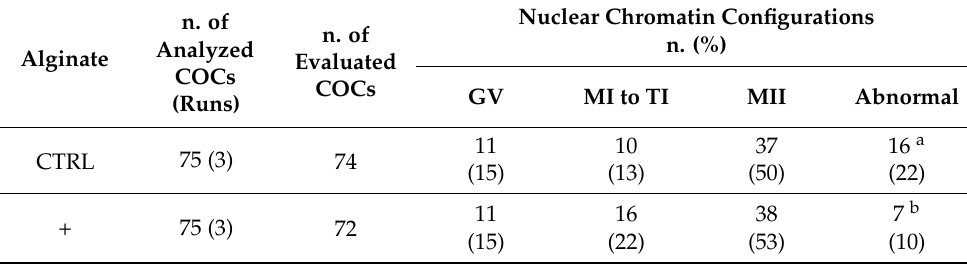
Figure 6. Effects of mIVM on sheep oocyte bioenergetic/oxidative status. Photomicrographs showing representative images of matured oocytes derived from static IVM (CTRL; ( a )); native mIVM ( b ); in alginate-filled supports ( c ). Corresponding epifluorescence images showing nuclear chromatin configuration (column 1: Hoechst 33258) and confocal images showing perinuclear and subplasmalemmal (P/S; ( a , c )) or finely granular ( b ) mitochondrial distribution pattern and activity (column 2: MitoTracker Orange CMTM Ros), intracellular ROS localization and levels (column 3: DCDHF DA), and mitochondria/ROS colocalization (column 4: Merge). Confocal images were taken at the oocyte equatorial plane. Scale bars represent 40 μ m. Table 6. Effects of mIVM in alginate-filled supports on sheep oocyte nuclear